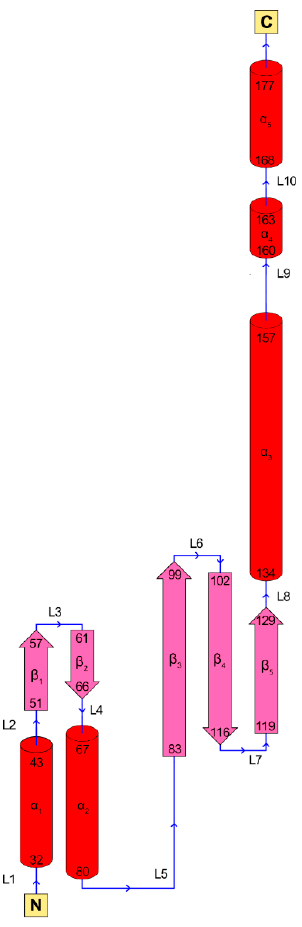
Figure 5. Side and bottom views of the mushroom-like structure of the undecameric ring of RAD52 (1–212) (PDB 1KN0). Molecular graphics and analyses were performed with UCSF Chimera, developed by the Resource for Biocomputing, Visualization, and Informatics at the University of California, San Francisco [61].